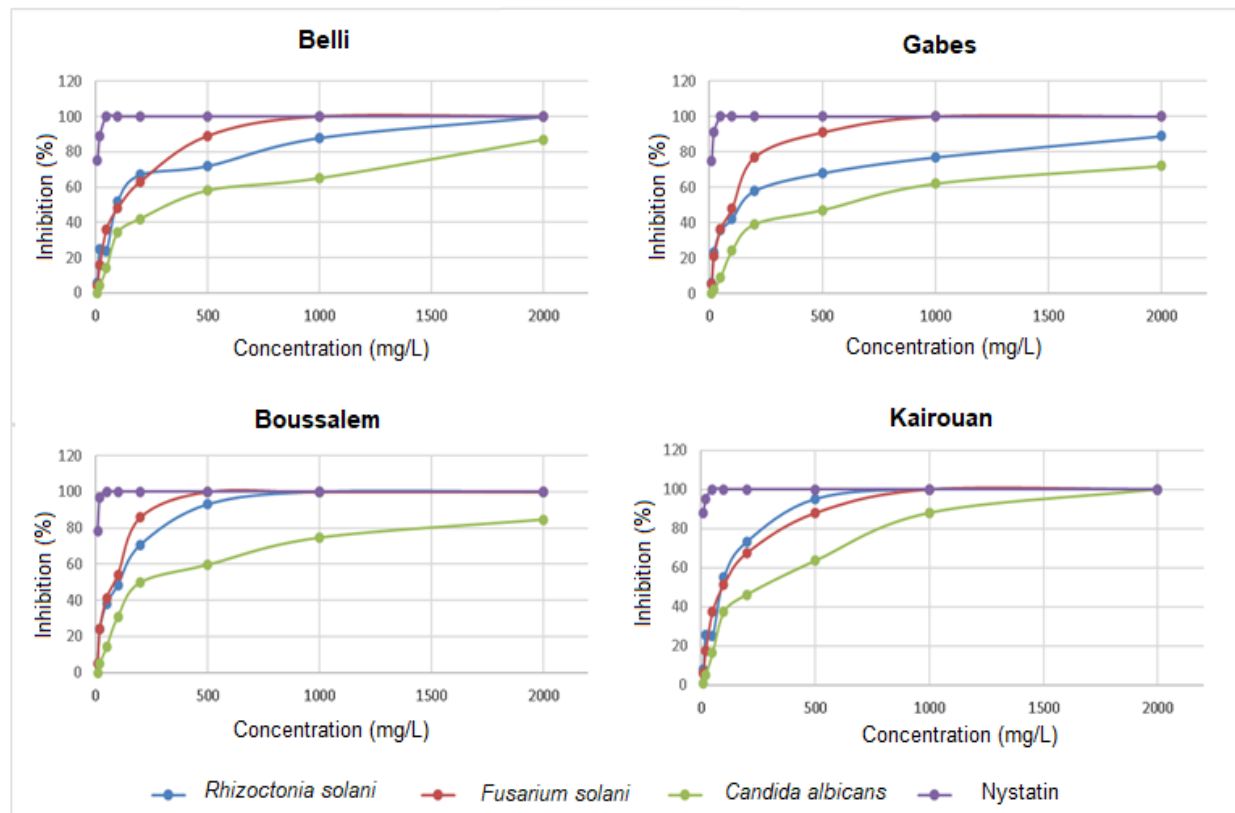
Figure 3. Variation in the percentages of inhibition of Rhizoctonia solani, Fusarium solani, Candida albicans and Nystatin depending on the location of collection. The values are the average of three replicates.